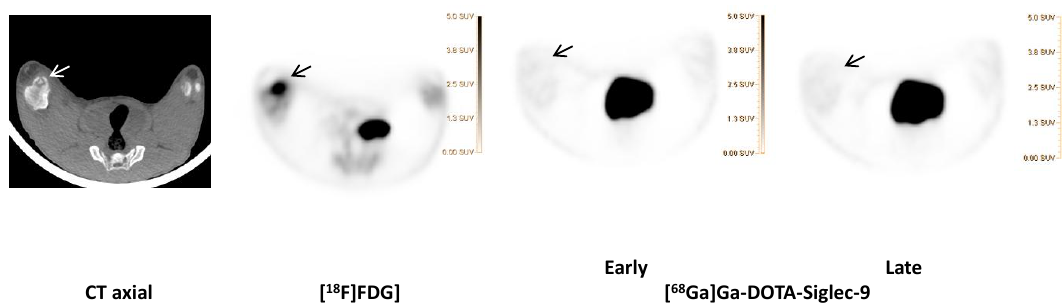
Figure 6. [ 68 Ga]Ga-DOTA-Siglec-9 compared to [ 18